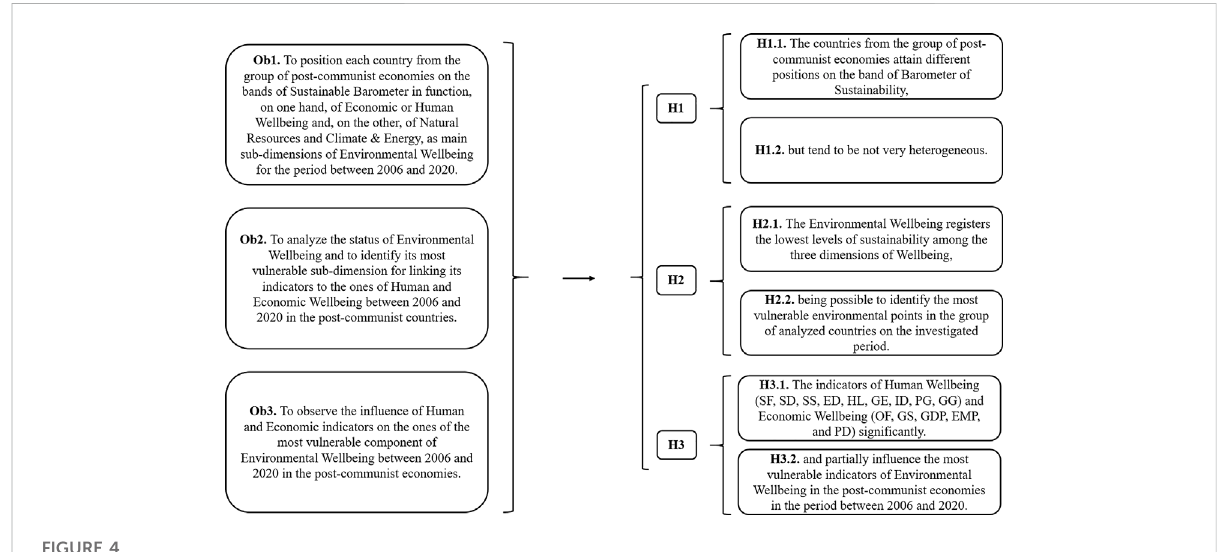
FIGURE 4 Main objectives and hypotheses of the